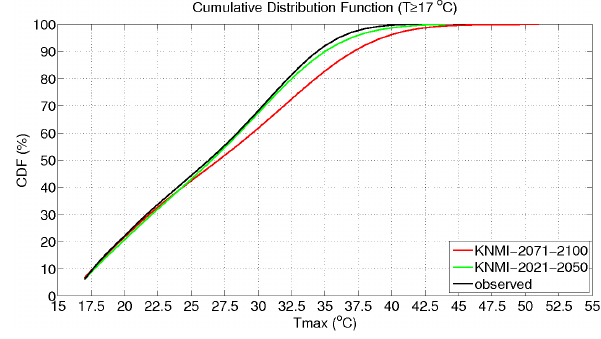
Figure 6. Cumulative distributions functions of temperature above 17 0 C for the three periods, the observed (1990-1999) (black), the 2021-2050 (green) and the 2071-2100 (red).